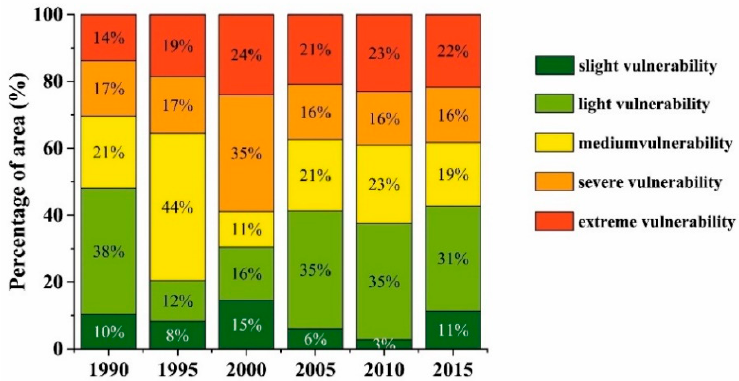
Figure 3. Proportion of ecological vulnerability of Shannan in 1990–2015.